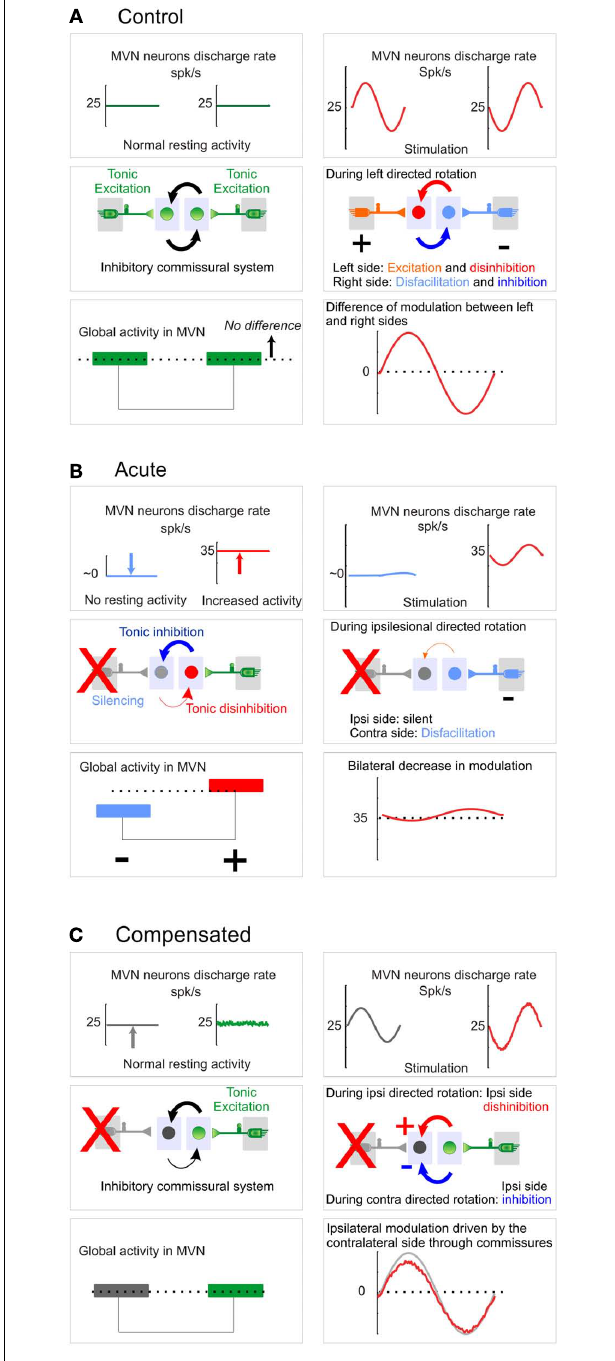
FIGURE 3 |Vestibular nuclei activity at control, acute, or compensated stage. For (A–C) , Left panels: resting condition; right panels: during sinusoidal movement.Top, middle, and bottom panels represent respectively the average discharge in left and right vestibular nuclei, the excitatory/inhibitory relations between 1˚ and 2˚VN (MVN) as well as the influence of commissural inhibition, and finally the resting balanced activity (left) and global modulation of activity (right) within vestibular nuclei. (A) Control.Vestibular nuclei work as a symmetrical, push–pull system, with a